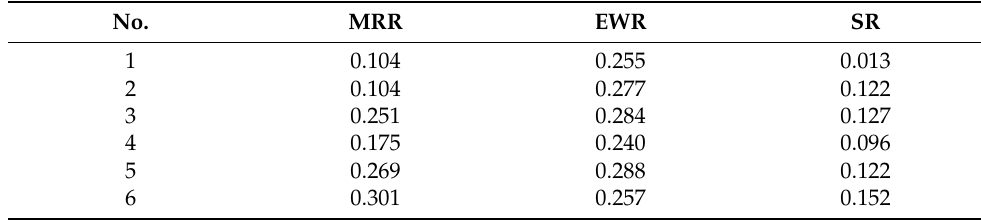
Table 11. Weighted normalized decision